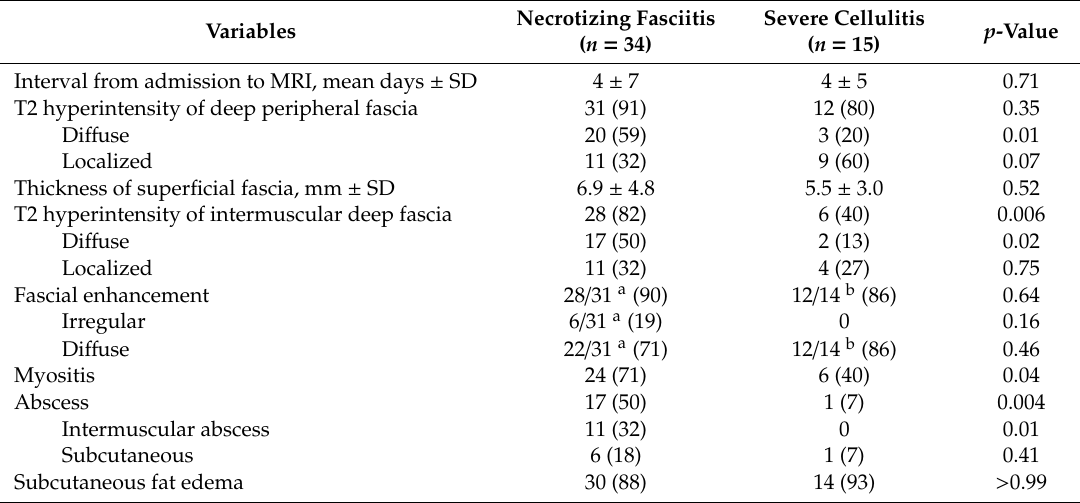
Table 2. Magnetic resonance findings of necrotizing fasciitis and severe cellulitis.